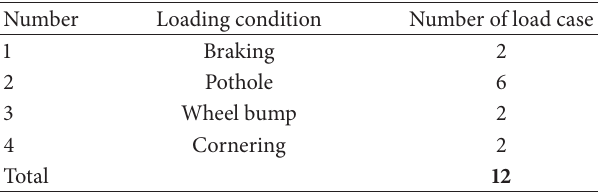
Figure 4: FE model for stiffness analysis of forward-braking case. Table 2: Loading condition and case for stiffness. Figure 5: Stiffness analysis result at pothole loading